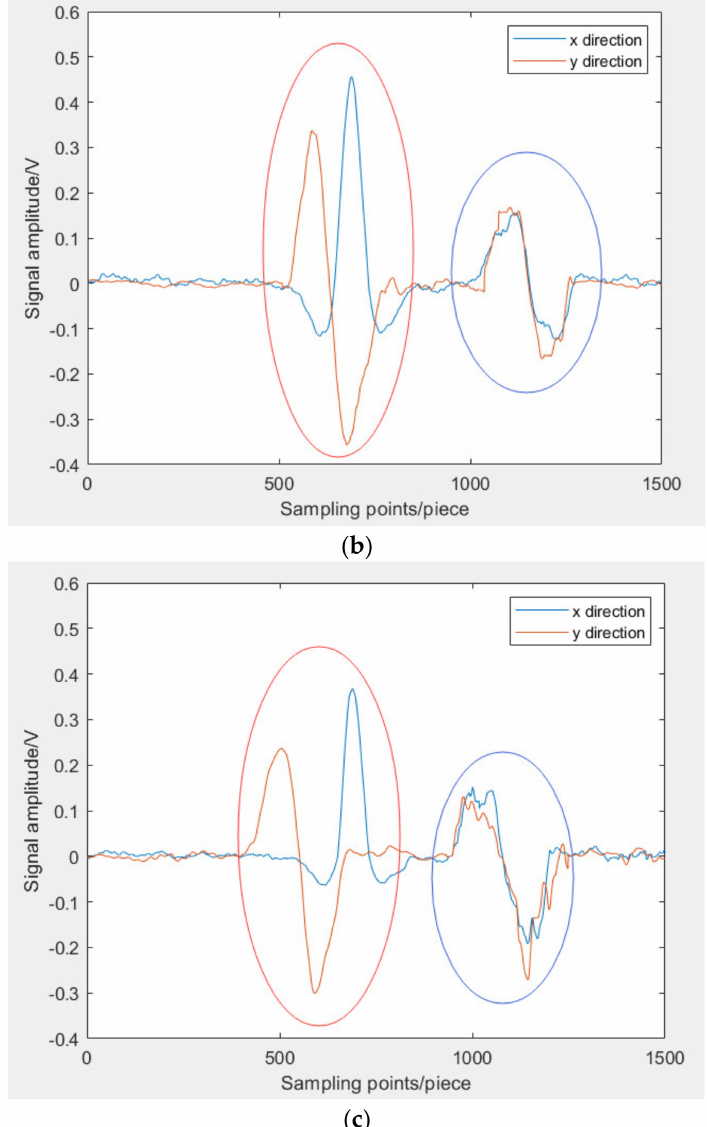
Figure 10. Detection results with different distances. ( a ) 1.8 mm; ( b ) 2.2 mm; ( c ) 2.6